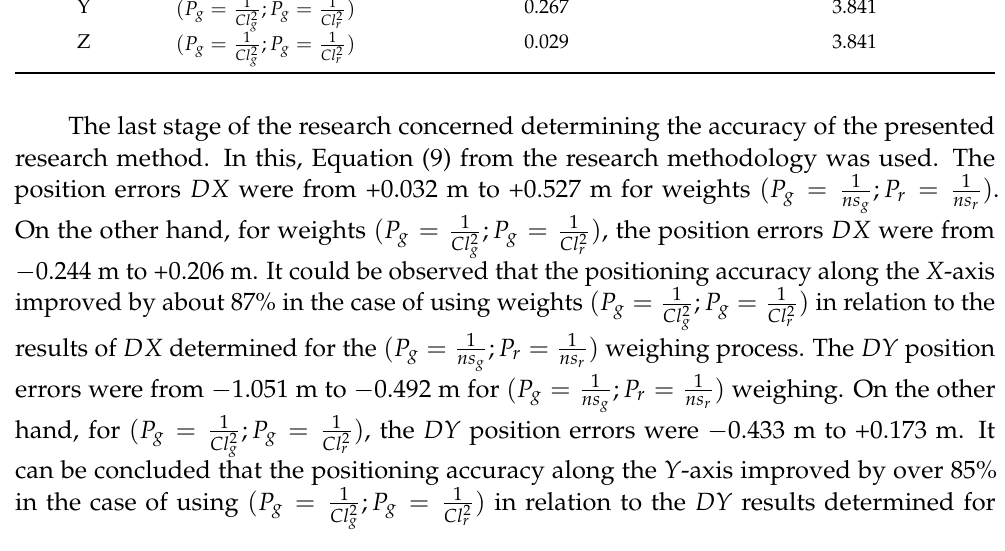
Table 1. The results of the global chi-square test.